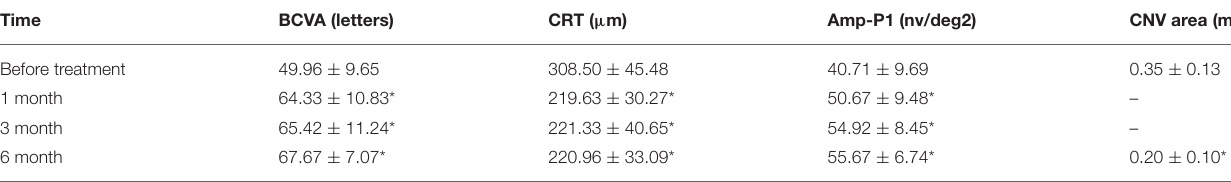
TABLE 2 | BCVA, CRT, Amp-P1 before and after treatment ( x ± s n = 24). Time Before